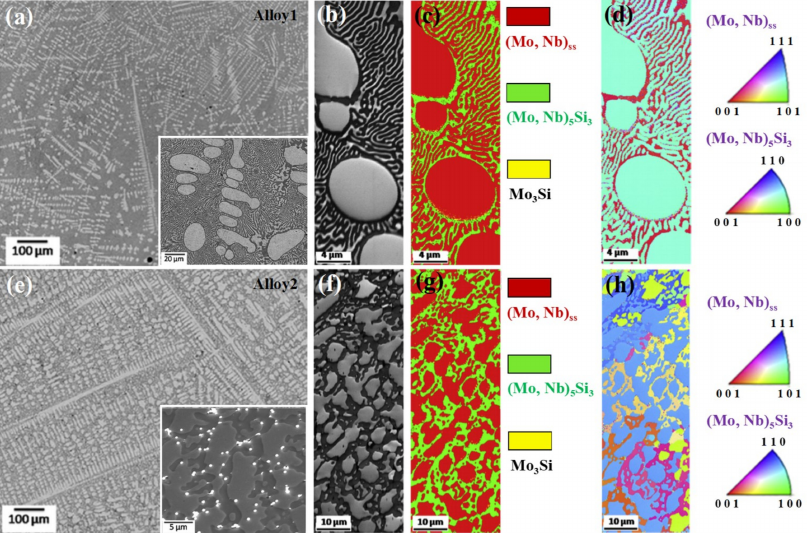
Figure 13. Microstructure morphologies of Alloy1 ( a ) and Alloy2 ( e ); EBSD mappings of Alloy1 and Alloy2: band contrast ( b , f ), phase ( c , g ), IPF ( d , h ). Reproduced with permission [143]. Copyright 2018